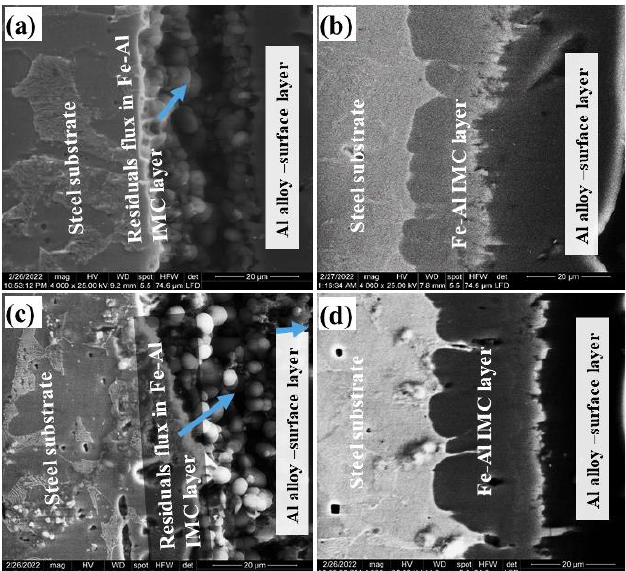
steel substrates (Figure 6b,d), as the thickness of the IMC layer increased by increasing dipping time.